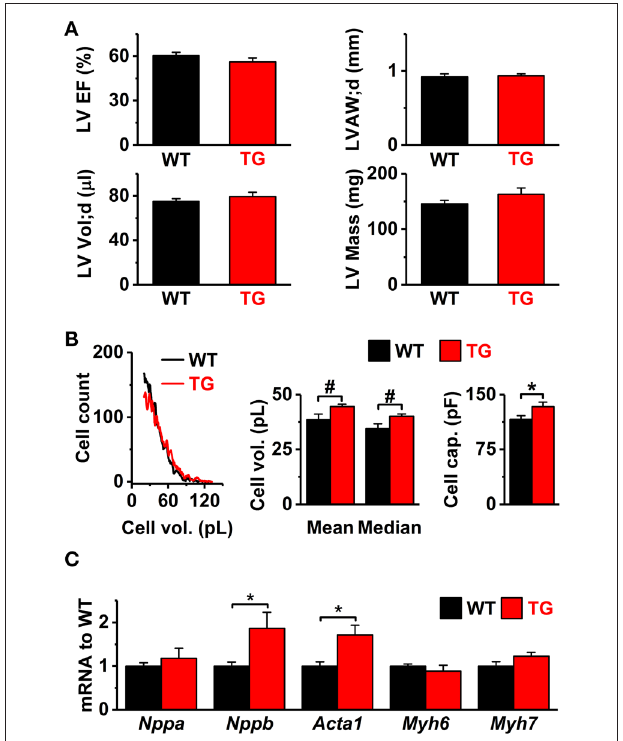
FIGURE 1 | In vivo cardiac function, cell size, and gene expression of hypertrophy markers in VEGF-B mice. (A) In vivo echocardiography data of left ventricle (LV): ejection fraction (LV EF%, upper left), diastolic anterior wall thickness (LVAW;d, upper right), diastolic volume (LV Vol;d, lower left), and mass (LV Mass, lower right, n = 10 for both groups). (B) Size of the isolated cardiomyocytes. Left panel: representative Coulter Counter histograms. Middle panel: average of means and medians from populations of cells isolated from hearts (WT; six hearts, 4152 ± 1770 cells/analysis TG; seven hearts, 6,040 ± 1,533 cells/analysis). Right panel: means of cell capacitances measured in whole-cell experiments (WT n = 8/51 and TG n = 10/58; animals/cells). (C) Gene markers of cardiac hypertrophy [mRNA to WT ratio: natriuretic peptide A ( Nppa ), natriuretic peptide B ( Nppb ), skeletal actin ( Acta1 ), myosin heavy polypeptide 6 ( Myh6 ), and myosin heavy polypeptide 7 ( Myh7 ); WT n = 7 and TG n = 6]. * P < 0.05, # P <